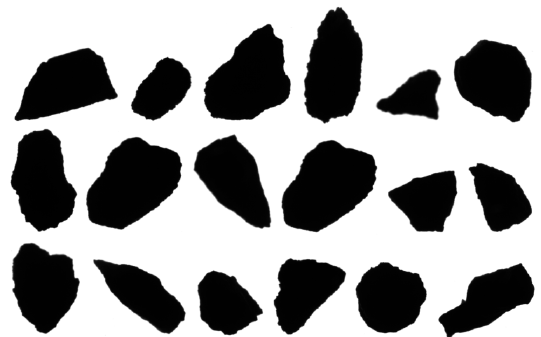
Figure 7. Regular particles of chalcedonite feed in particle size fraction 6.3–8 mm.